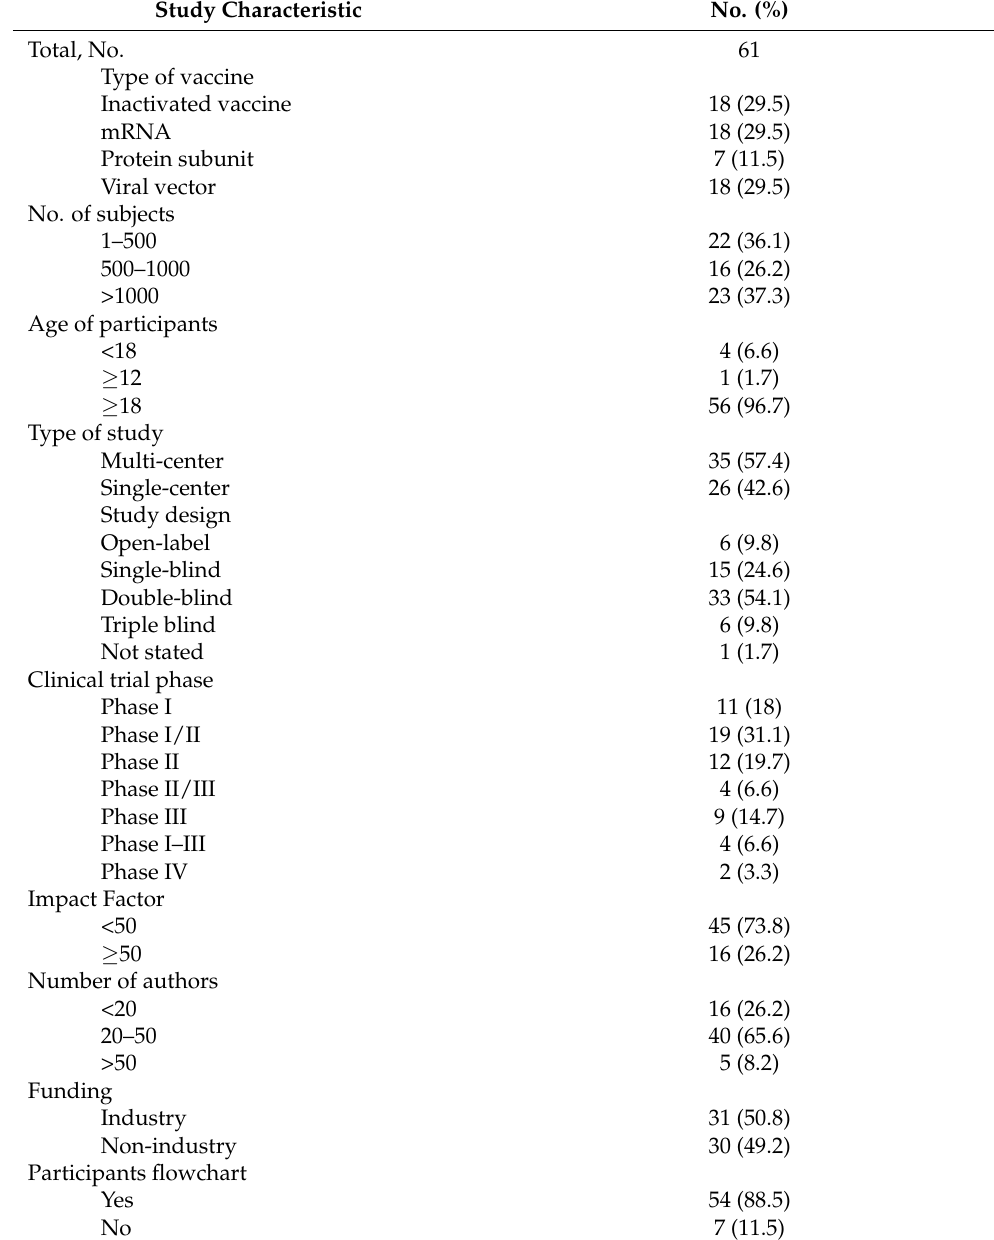
Table 1. Characteristics of Eligible